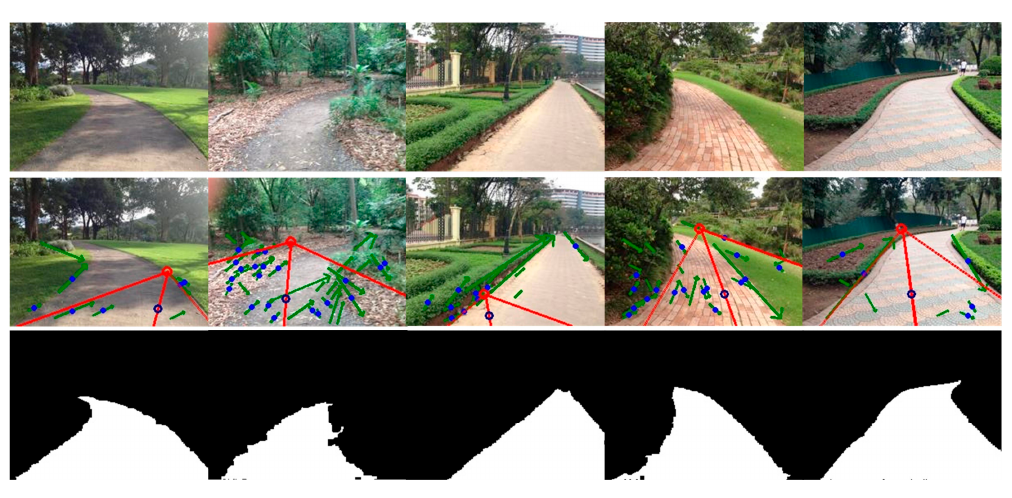
Figure 9. Segmentation accuracy with different methods on the KITTI road benchmark (unmarked lane subset of KITTI).